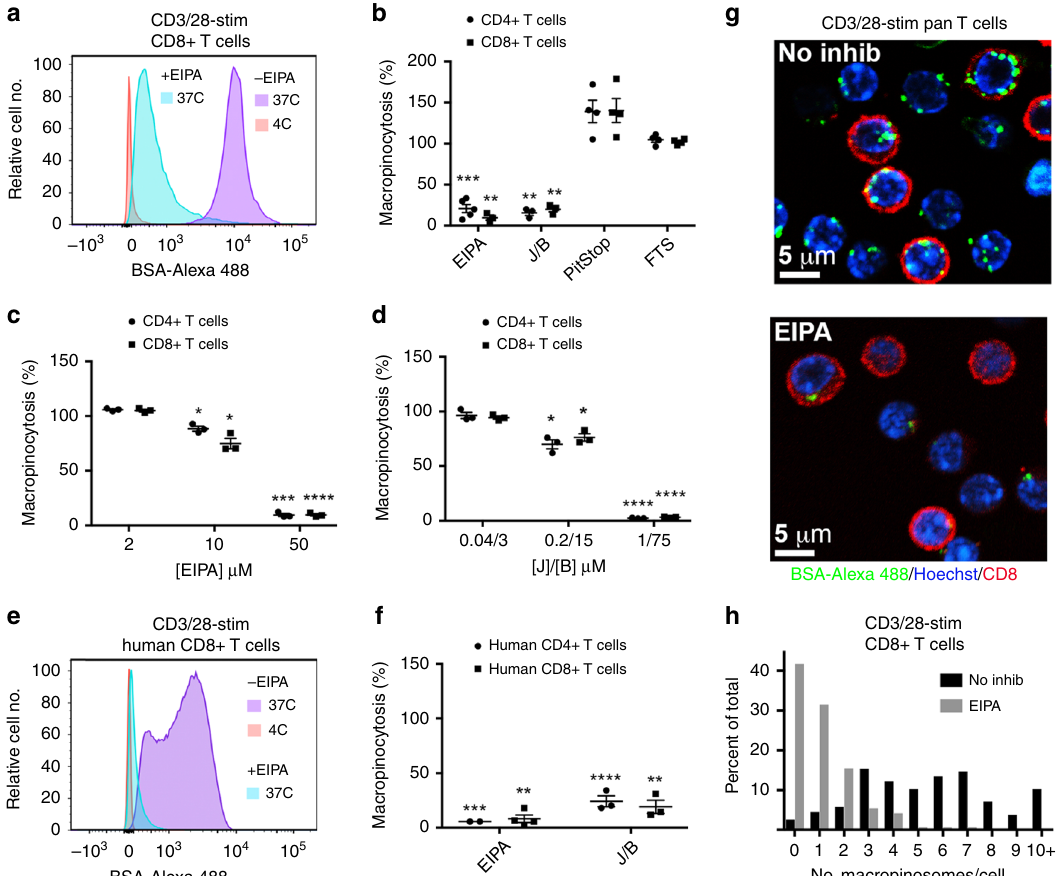
Fig. 3 Inhibitors of macropinocytosis block T cell uptake of BSA. a – f Murine splenocytes ( a – d ) or human PBMC ( e , f ) were stimulated with CD3/28 mAb for 12 h before incubation with BSA-Alexa 488 at 37 °C or 4 °C in the presence or absence of the indicated inhibitors for a further 8 h. In ( a , b , e , f ), EIPA and J/B were used at the highest concentrations shown in ( c ) and ( d ), respectively. a , e Representative fl ow cytometry plots showing the in fl uence of EIPA upon probe uptake by CD8 + T cells. b – d , f , Mean ± 1 SEM of the percentage macropinocytosis relative to the positive control, calculated as indicated in Methods. b (EIPA, n = 5 for CD4 + and n = 3 for CD8 + ; J/B, n = 3; Pitstop, n = 4; FTS, n = 4 independent experiments). c , d n = 3 independent experiments. f n = 2 and 4 independent experiments for CD4 + and CD8 + , respectively, with EIPA and n = 3 independent experiments for J/B. * P < 0.05, ** P < 0.01, *** P < 0.001, **** P < 0.0001 by Student ’ s 1-sample 2-sided t -test. g BSA-Alexa 488 uptake by CD3/28 mAb-stimulated puri fi ed murine T cells (probe incubation from 12 to 20 h) in the absence and presence of EIPA at 37 °C. Images are representative of fi ve repeat experiments. h Quantitation of the number of macropinosomes per CD8 + T cell in the absence and presence of EIPA ( n = 156 and 168 cells, respectively). Source data are provided as Source Data fi